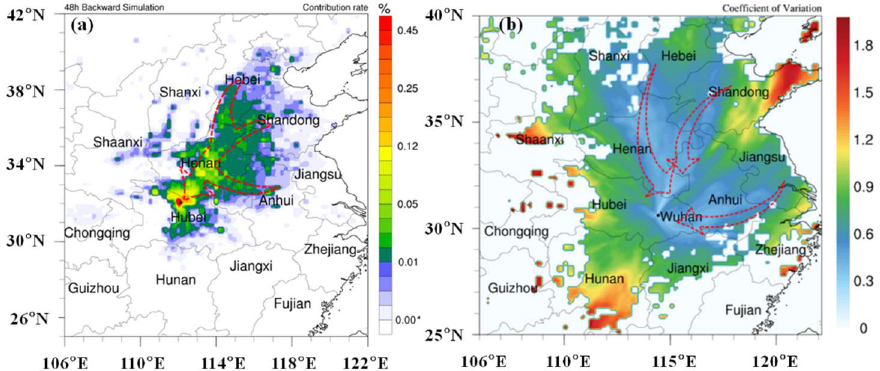
Figure 6. ( a ) Distribution of average contribution rates (color contours) to PM 2.5 concentrations in Xiangyang, THB during 30 HPEs for 2015–2019, with the major routes of regional transport over CEC (dashed line), ( b ) spatial distribution of variation coefficients for the contribution rates to wintertime PM 2.5 concentrations in Wuhan, a capital city in the THB with the larger values of variation coefficients representing the stronger inter-annual variations over recent years.